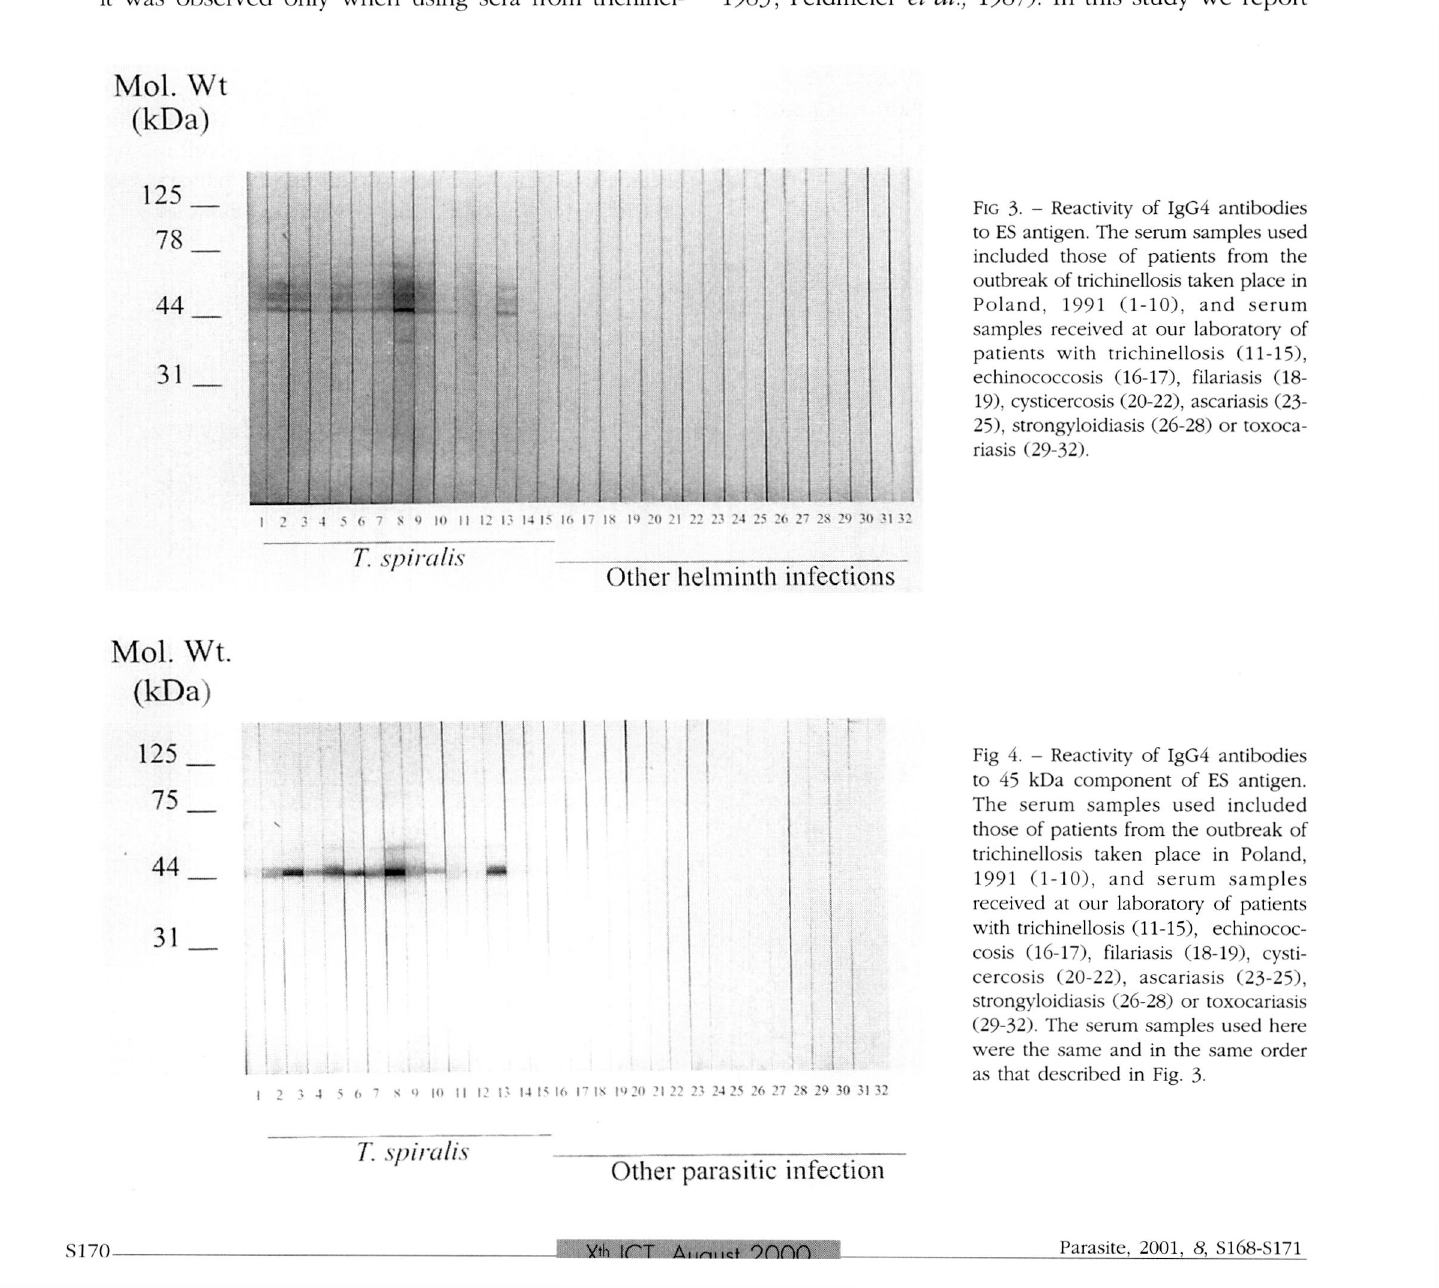
Fig 4. - Reactivity of IgG4 antibodies to 45 kDa component of ES antigen. The serum samples used included those of patients from the outbreak of trichinellosis taken place in Poland, 1991 (1-10), and serum samples received at our laboratory of patients with trichinellosis (11-15), echinococ cosis (16-17), filariasis (18-19), cysti cercosis (20-22), ascariasis (23-25), strongyloidiasis (26-28) or toxocariasis (29-32). The serum samples used here were the same and in the same order as that described in Fig.